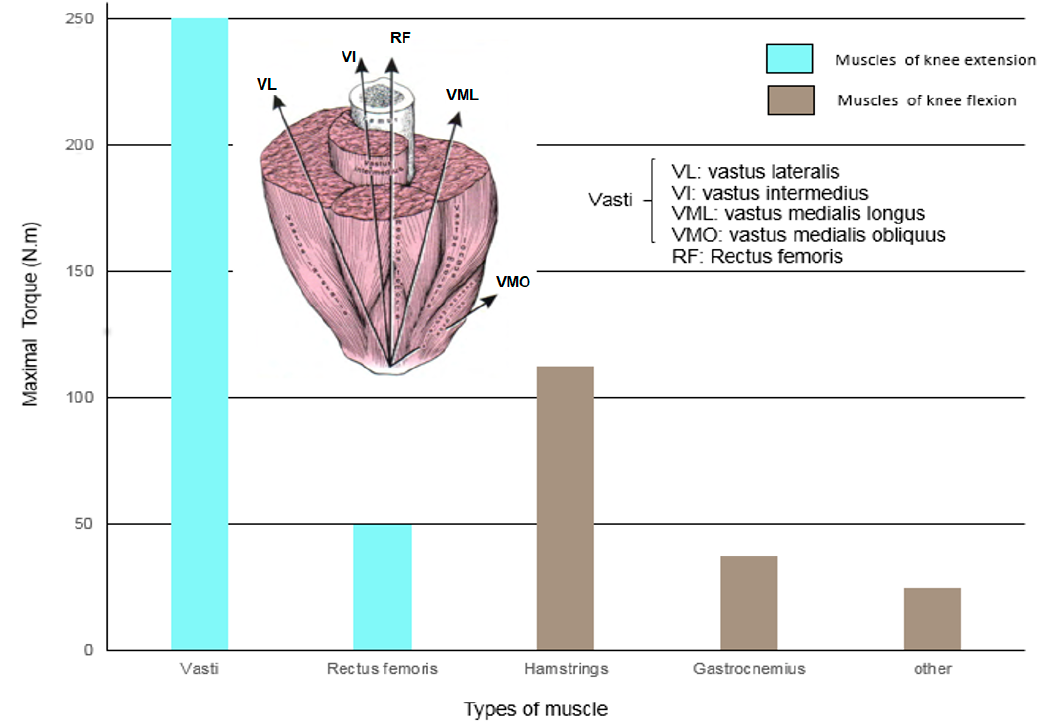
Figure 1. The maximum torque at muscles across the knee.